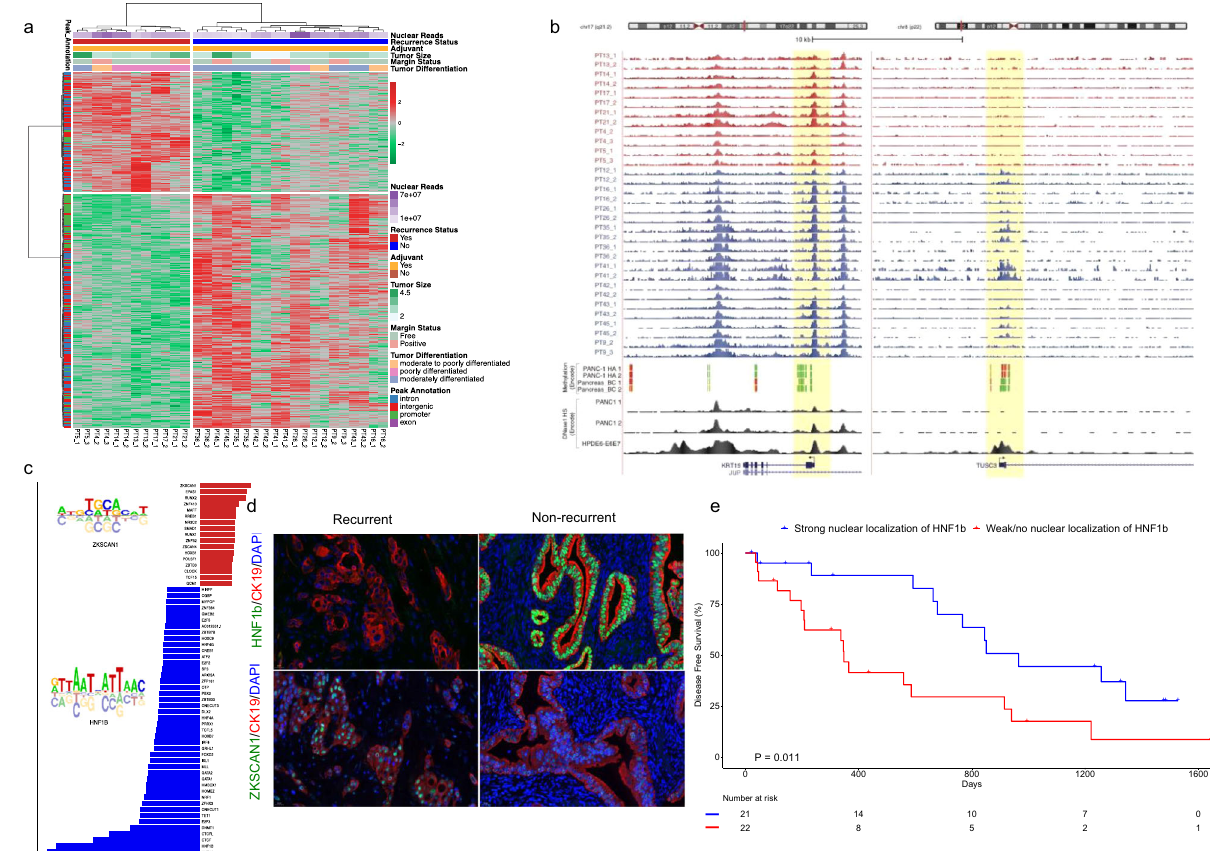
Fig. 1 Differential chromatin accessibility signature and transcription factor nuclear localization predict prognosis of resected PDAC. a Differential ATAC-seq peaks in recurrent versus non-recurrent patients (Source data are provided as a Source Data fi le). b Upper panel depicts genome browser tracks showing ATAC-seq peaks at KRT19 and TUSC3 gene loci for duplicate samples from individual patients (PT); lower panel shows corresponding ENCODE methylation signals from Panc-1 and a normal pancreatic (BC) cell lines, (green denotes hypomethylation and red denotes hypermethylation) and DHS peak from Panc-1 and HPDE6-E6E7 cell lines. Highlighted yellow regions denote the promoter peaks of both the gene loci. All the track lines have the same Y axis limits and that the peak height is normalized by the total read depth of each sample. c Regression coef fi cients showing enrichment of transcription factor-binding sites in recurrent (red) and non-recurrent (blue) patients. d Representative images of TMA staining of HNF1b (upper panel) and ZKSCAN1 (lower panel) in recurrent and non-recurrent patients (TMA n = 43 with three replicated cores in each patient), Scale bars are 20 μ M as displayed at the left bottom corners of all the micrographs. e Kaplan – Meier curve of the patients with and without nuclear localization of HNF1b (log-rank (Mantel – Cox) test P = 0.011, HR 2.64, 95% CI 1.213 to 5.775). (Source data are provided as a Source Data fi